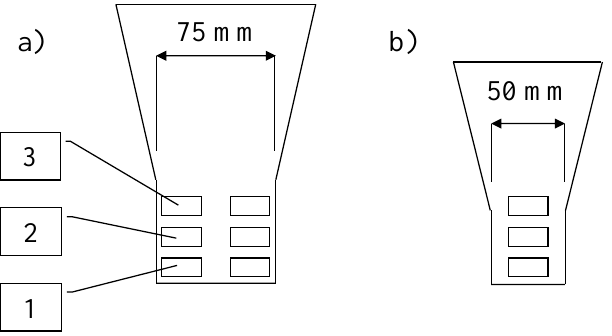
Figure 2. Position of fatigue specimens (rectangular cross section) taken from the Y-shaped type IV ( a ) and type III ( b ).